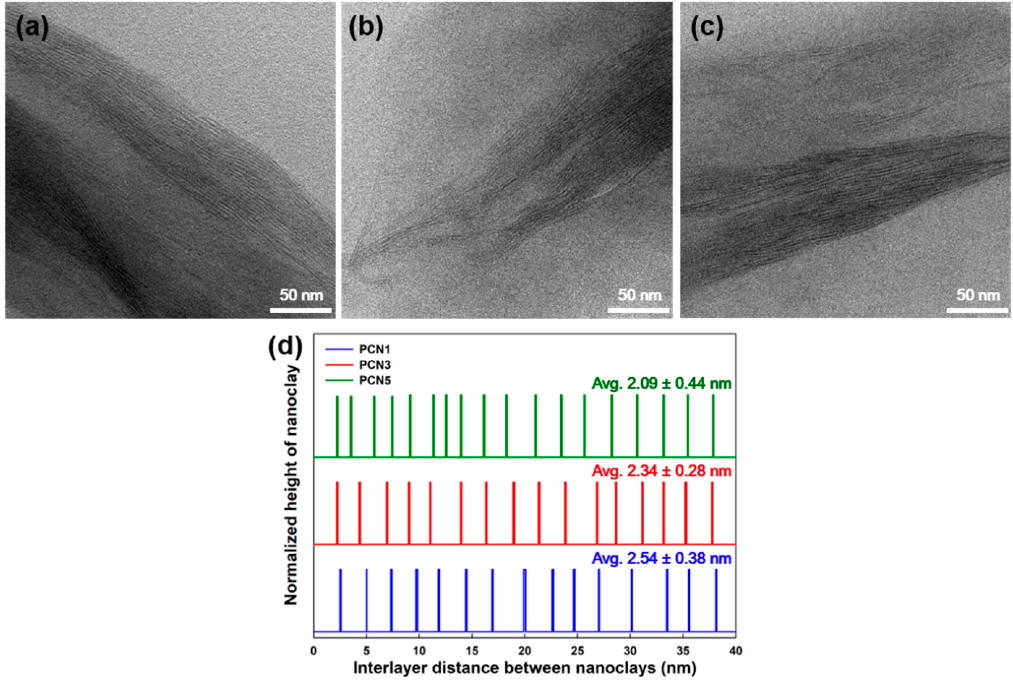
Figure 5. TEM micrographs of cross-section images of the ( a ) PCN1, ( b ) PCN3, and ( c ) PCN5 nanocomposites, and ( d ) interlayer distance of the intercalated nanoclay.